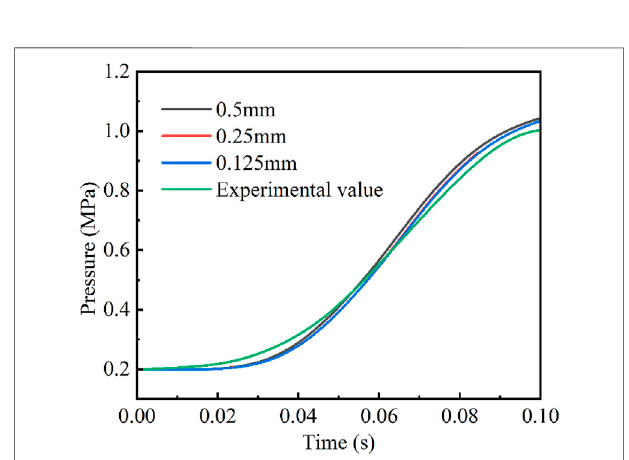
FIGURE 5 | Grid-independent analysis of the combustion chamber